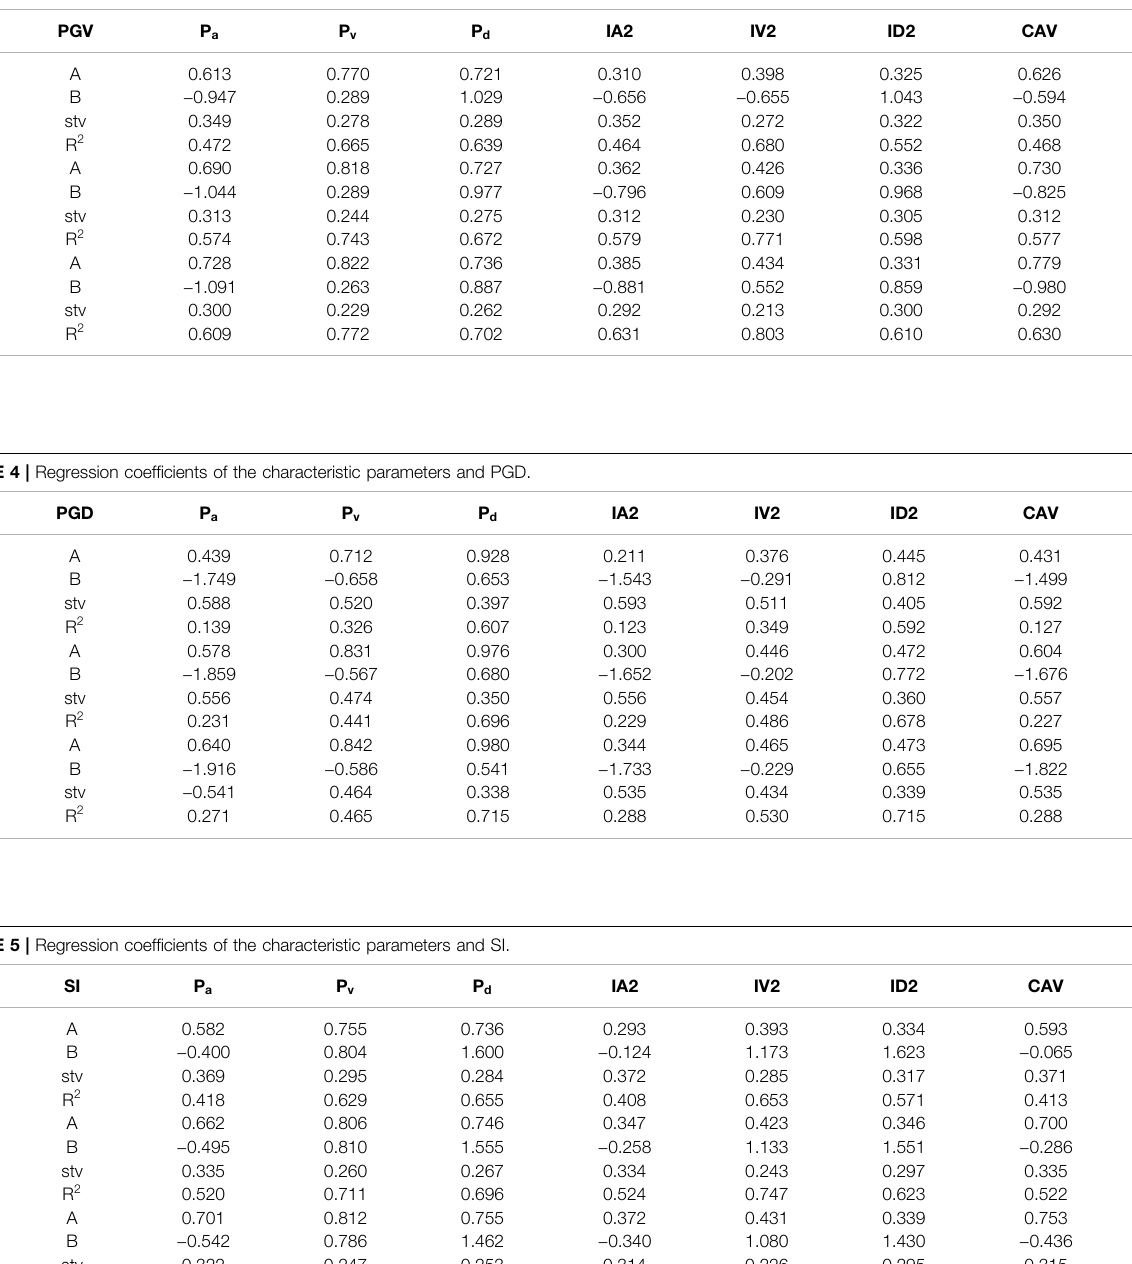
TABLE 3 | Regression coef fi cients of the characteristic parameters and PGV.